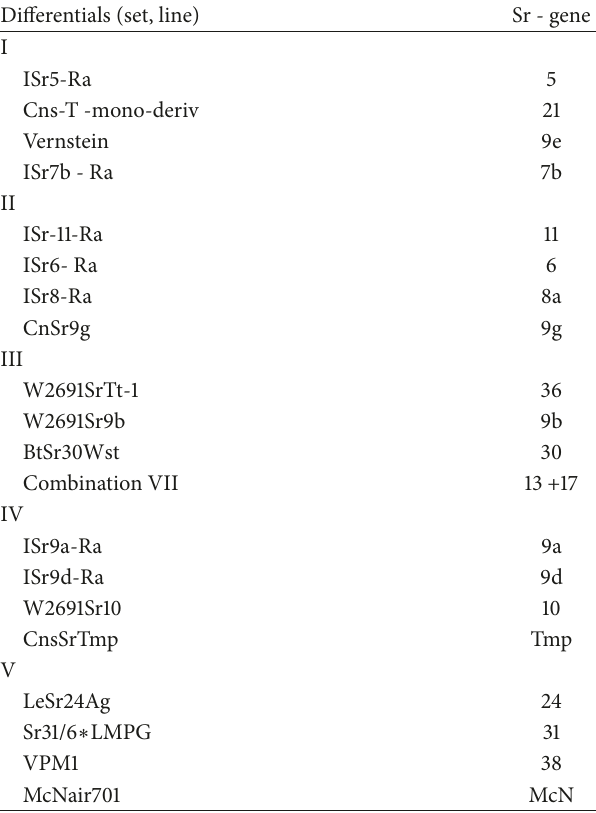
Table 1: List of 20 North American stem rust